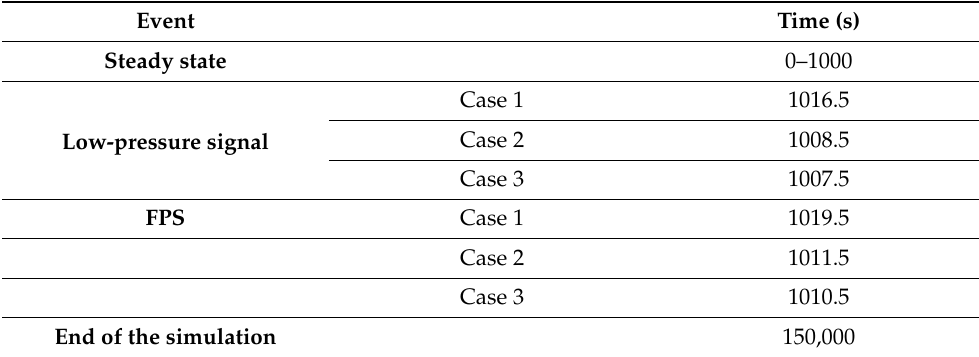
Table 15. Event sequence.